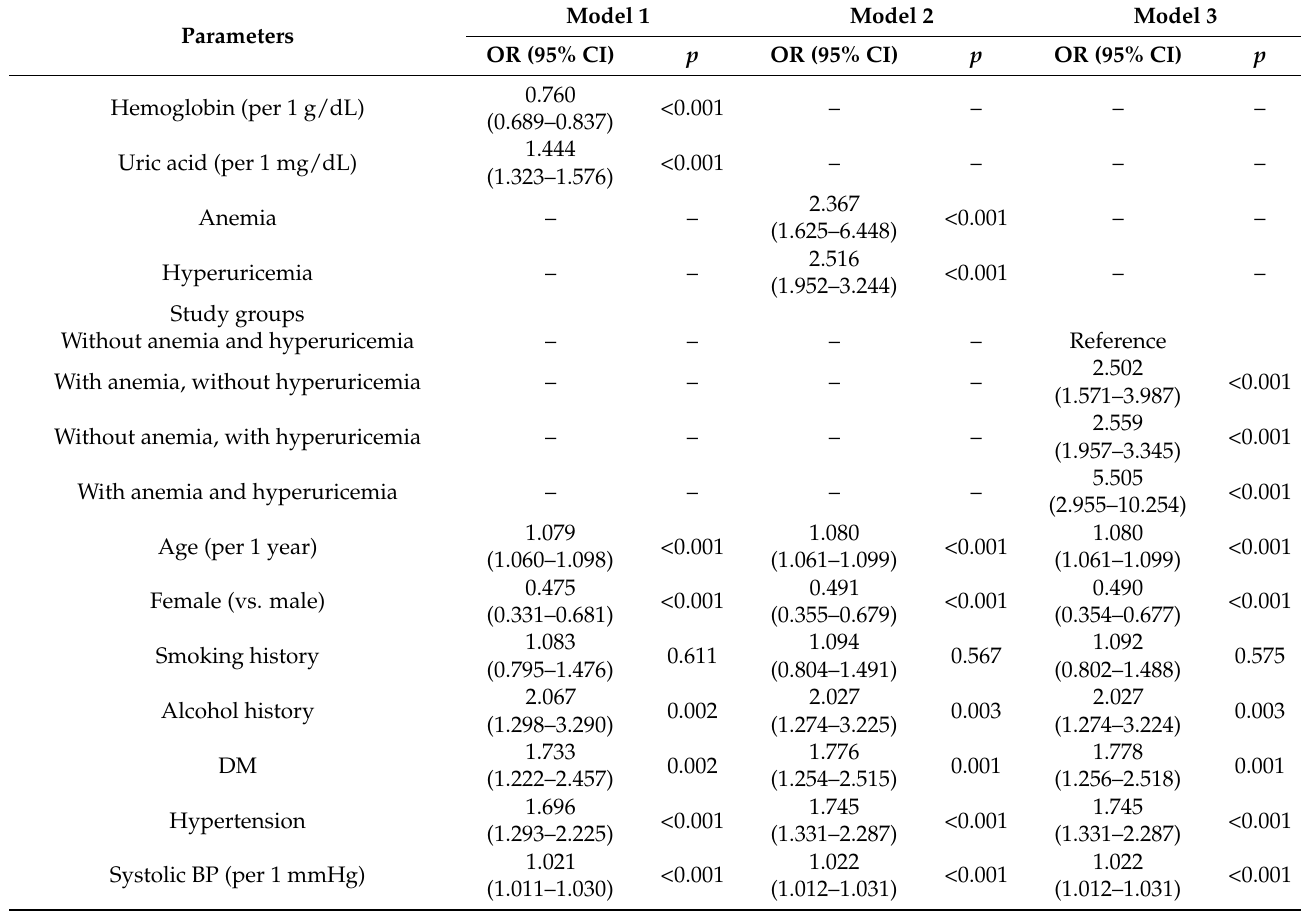
Table 3. Relation of hemoglobin, uric acid, anemia, hyperuricemia, and study groups and new-onset CKD using multivariable logistic regression